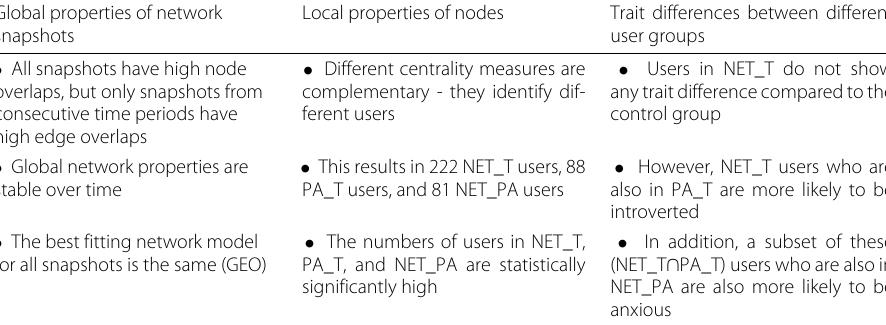
Global properties of network